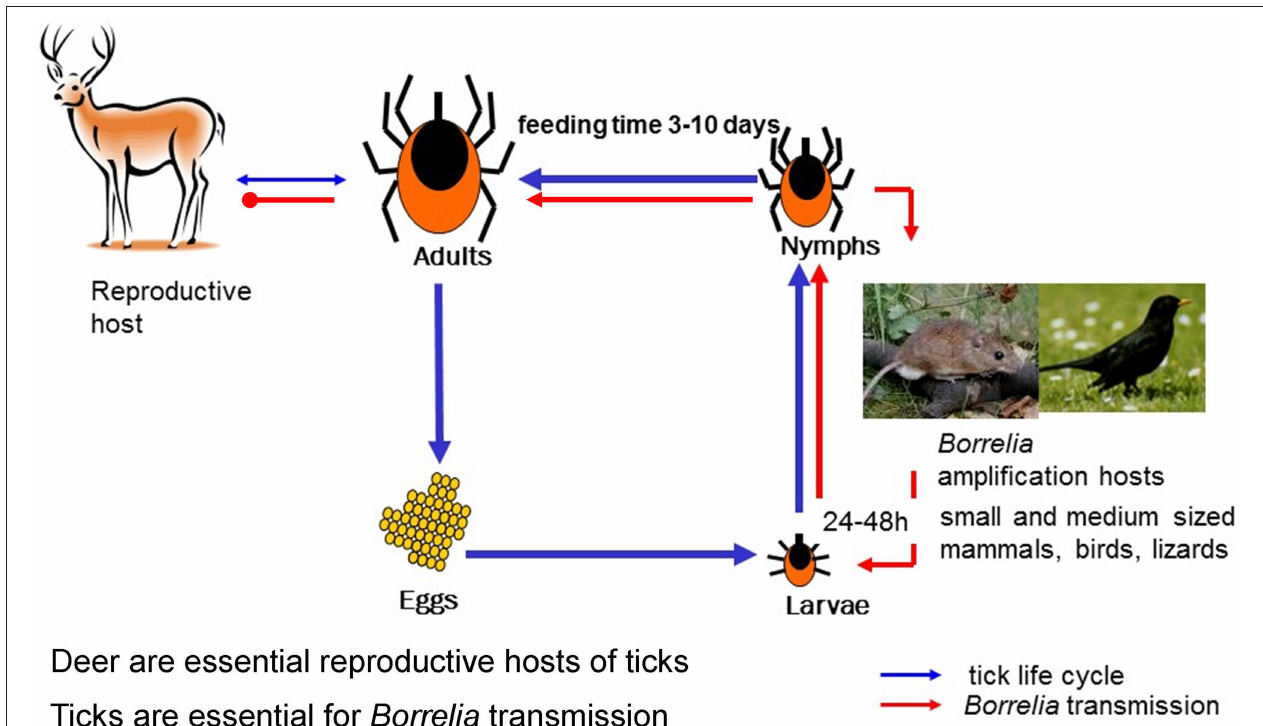
FIGURE 1 | Ixodes and Borrelia life cycle. The developmental time from egg to adult Ixodes tick depends on climate and environmental conditions and may take 2–7 years. Each of the stages, larvae, nymph and adult female take one blood meal that can—depending on the stage—last 3–10 days. Engorged ticks drop off the host, digest the blood meal, and molt into the next stage. Importantly, both, larvae and nymphs, prefer small to medium sized vertebrates as host. This and the questing phenology of these stages ensures transmission of Borrelia from host to vector and to the next host. Adult females prefer larger animals such as deer as host. Deer has been shown to be incompetent as Borrelia reservoir host but they are essential for maintaining tick populations. Humans are considered accidental hosts and are dead-end hosts for Borrelia .